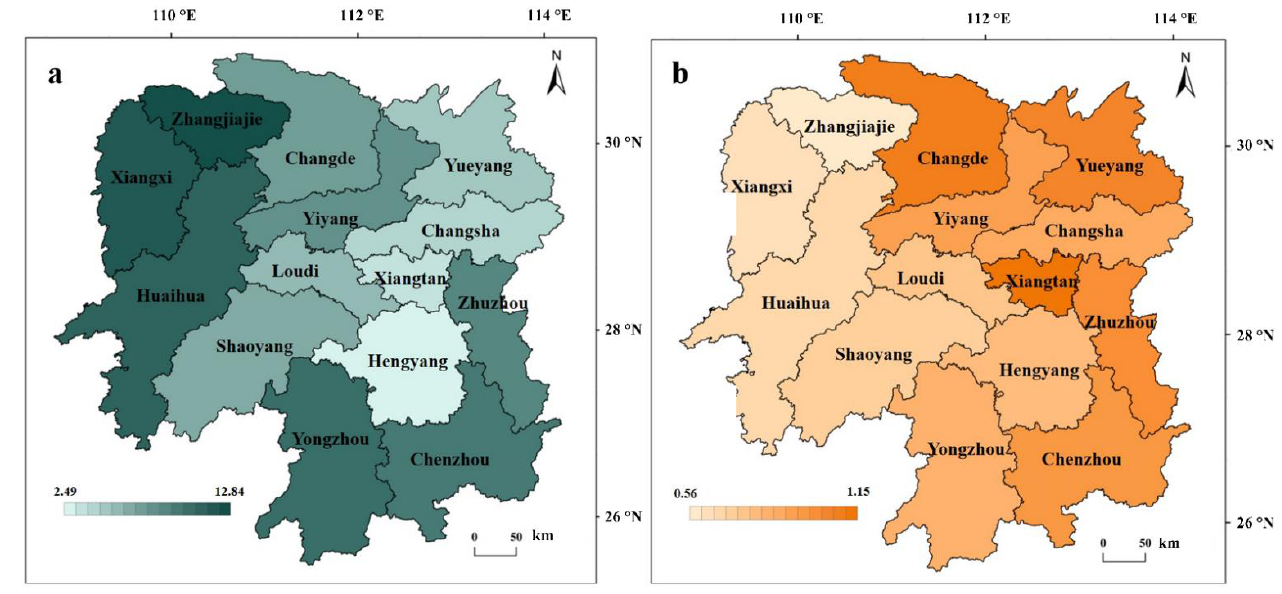
Figure 7. Average annual per capita EF w ( a ) and EC w ( b ) (hm 2 /per capita) over the 14 prefecture-level cities.